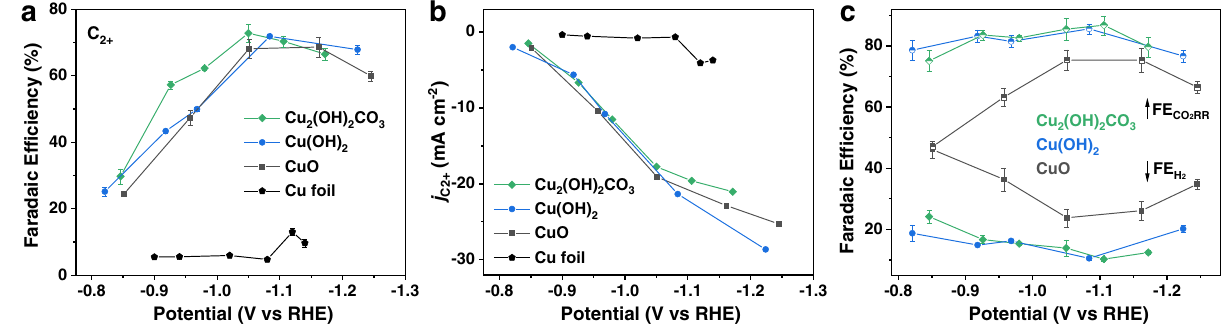
Fig. 2 | Electrocatalytic CO 2 RR performances. Comparison of a Faradaic ef fi - ciencyofC 2+ productsand b C 2+ partialcurrentdensityforCu 2 (OH) 2 CO 3 ,Cu(OH) 2 , andCuOnanocrystalsandCufoil.Dataarenormalizedusingthegeometricsurface area. c Comparison of Faradaic ef fi ciencies for overall CO 2 RR (FE CO